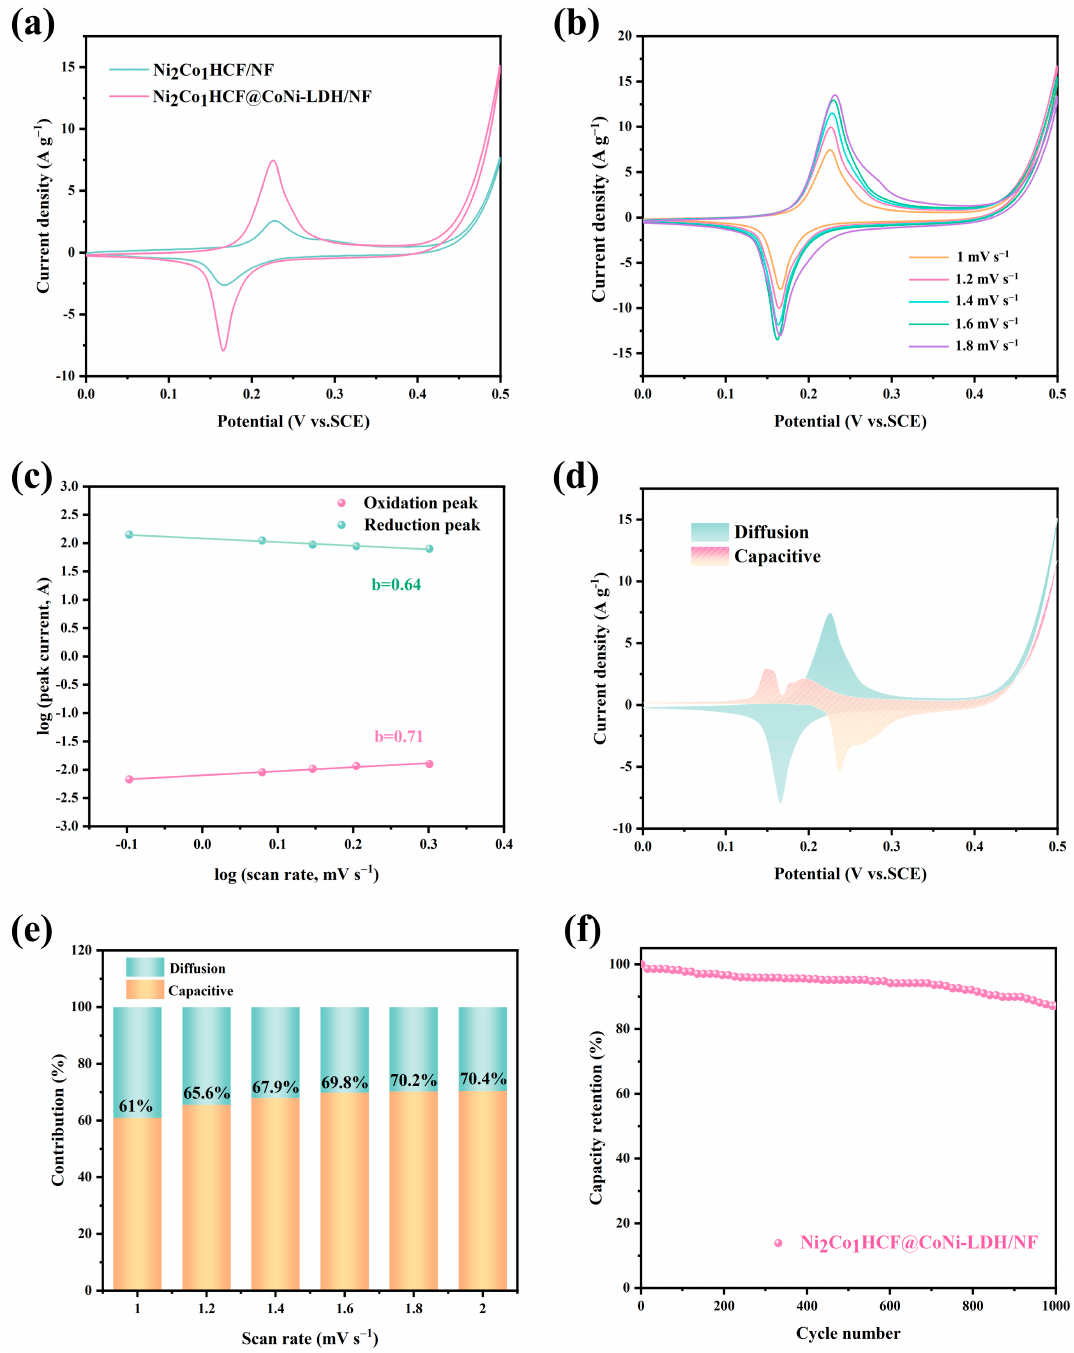
Figure 6. ( a ) Comparative CV curves of the Ni 2 Co 1 HCF/NF and Ni 2 Co 1 HCF@CoNi-LDH/NF composites; ( b ) CV curves at different scanning rates; ( c ) relationship between the logarithm of the peak cathode and anode currents and the logarithmic scan rate of the electrodes; ( d ) pseudocapacitance contribution versus diffusion contribution at a scan rate of 1 mV·s − 1 ; ( e ) contribution of pseudocapacitance at different scanning rates; ( f ) cycling stability curve at a current density of 5 A·g − 1 of the Ni 2 Co 1 HCF@CoNi-LDH/NF composites.